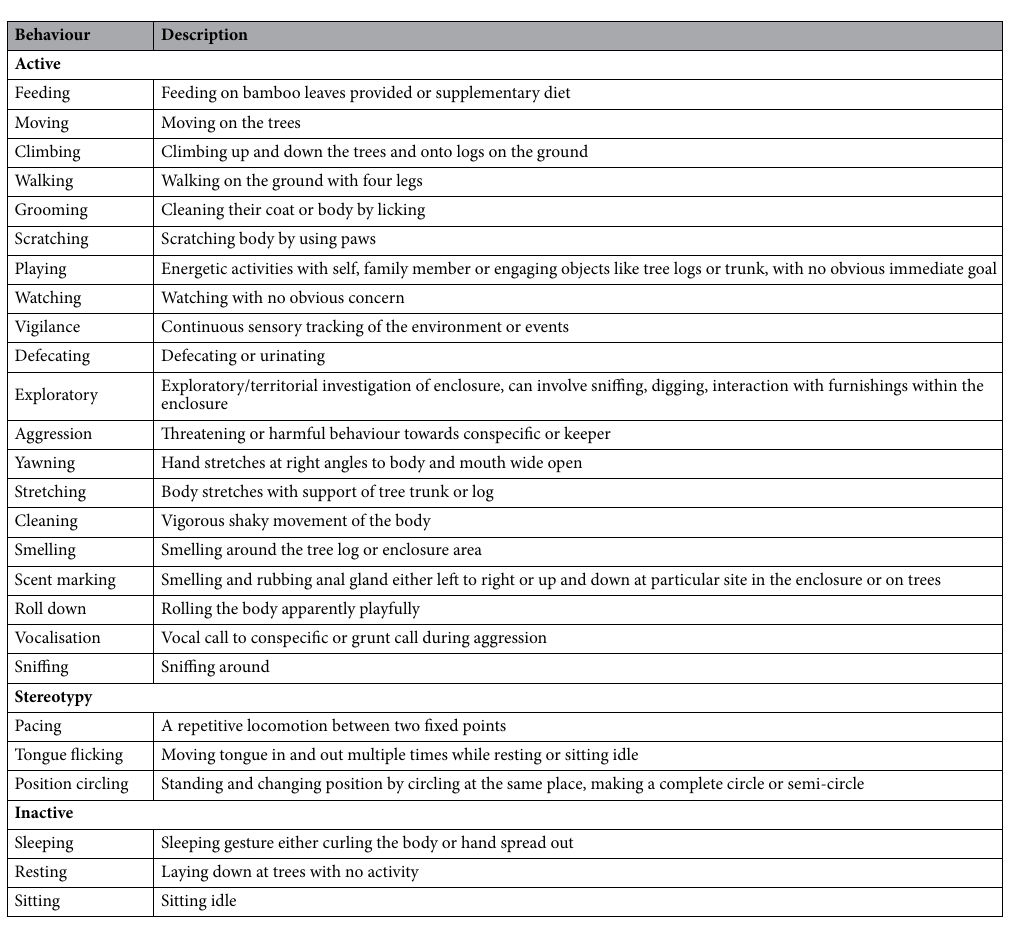
Table 4. Ethogram of captive panda at three zoos in